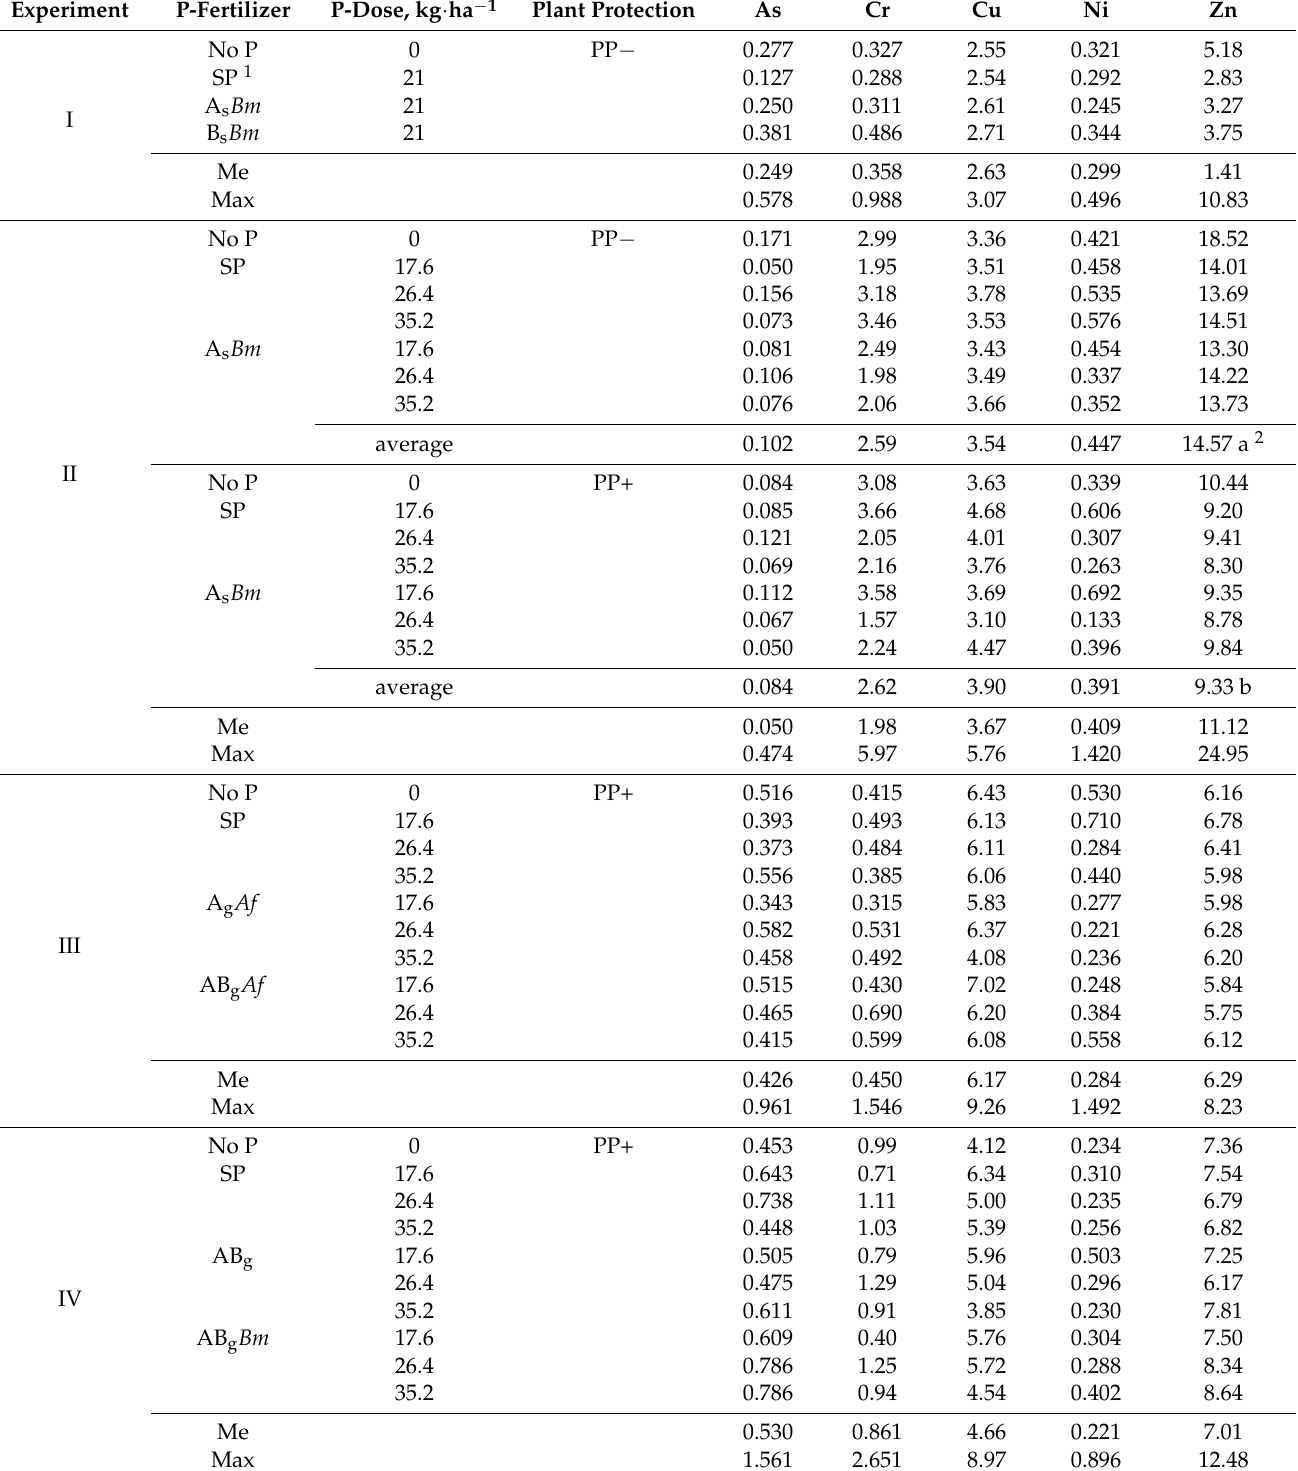
Table 12. PTE content in wheat straw, mg · kg − 1 DM (n = 4).